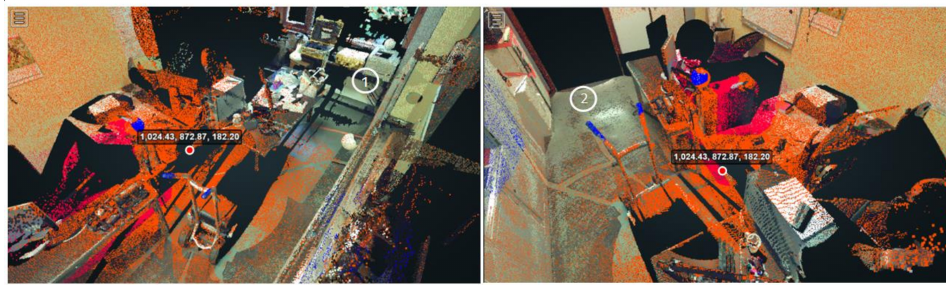
Figure 24. Influence of the projection centre position on the segmentation of the point